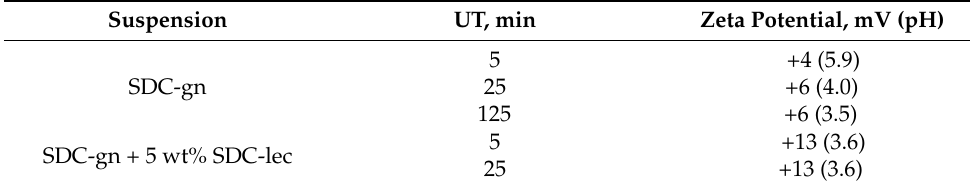
Table 2. Electrokinetic properties of the base suspension of the SDC-gn powder (10 g/L) and